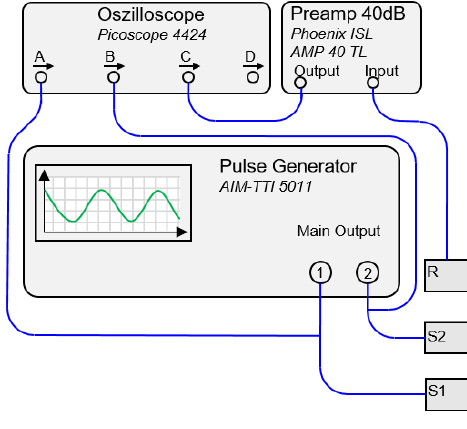
Figure 9. Experimental setup.